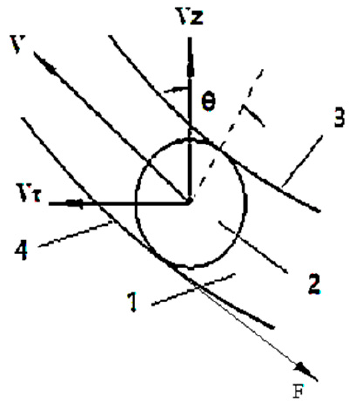
Figure 6. Velocity decomposition of the main roller with no clearance. Note: 1—cam curve slot, 2—main roller, F—the friction force, 3—the rear-end surface, and 4—the front-end surface. For the K roller group, the pure rolling of the mass transitional velocity matrix